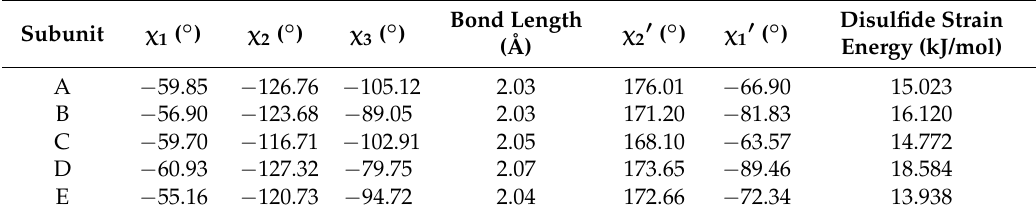
Table 3. Dihedral angles, bond lengths, and strain energies of the Cys55 ‐ Cys99 disulfides in the crystal structure of B. subtilis Glu97Gln QueF mutant.